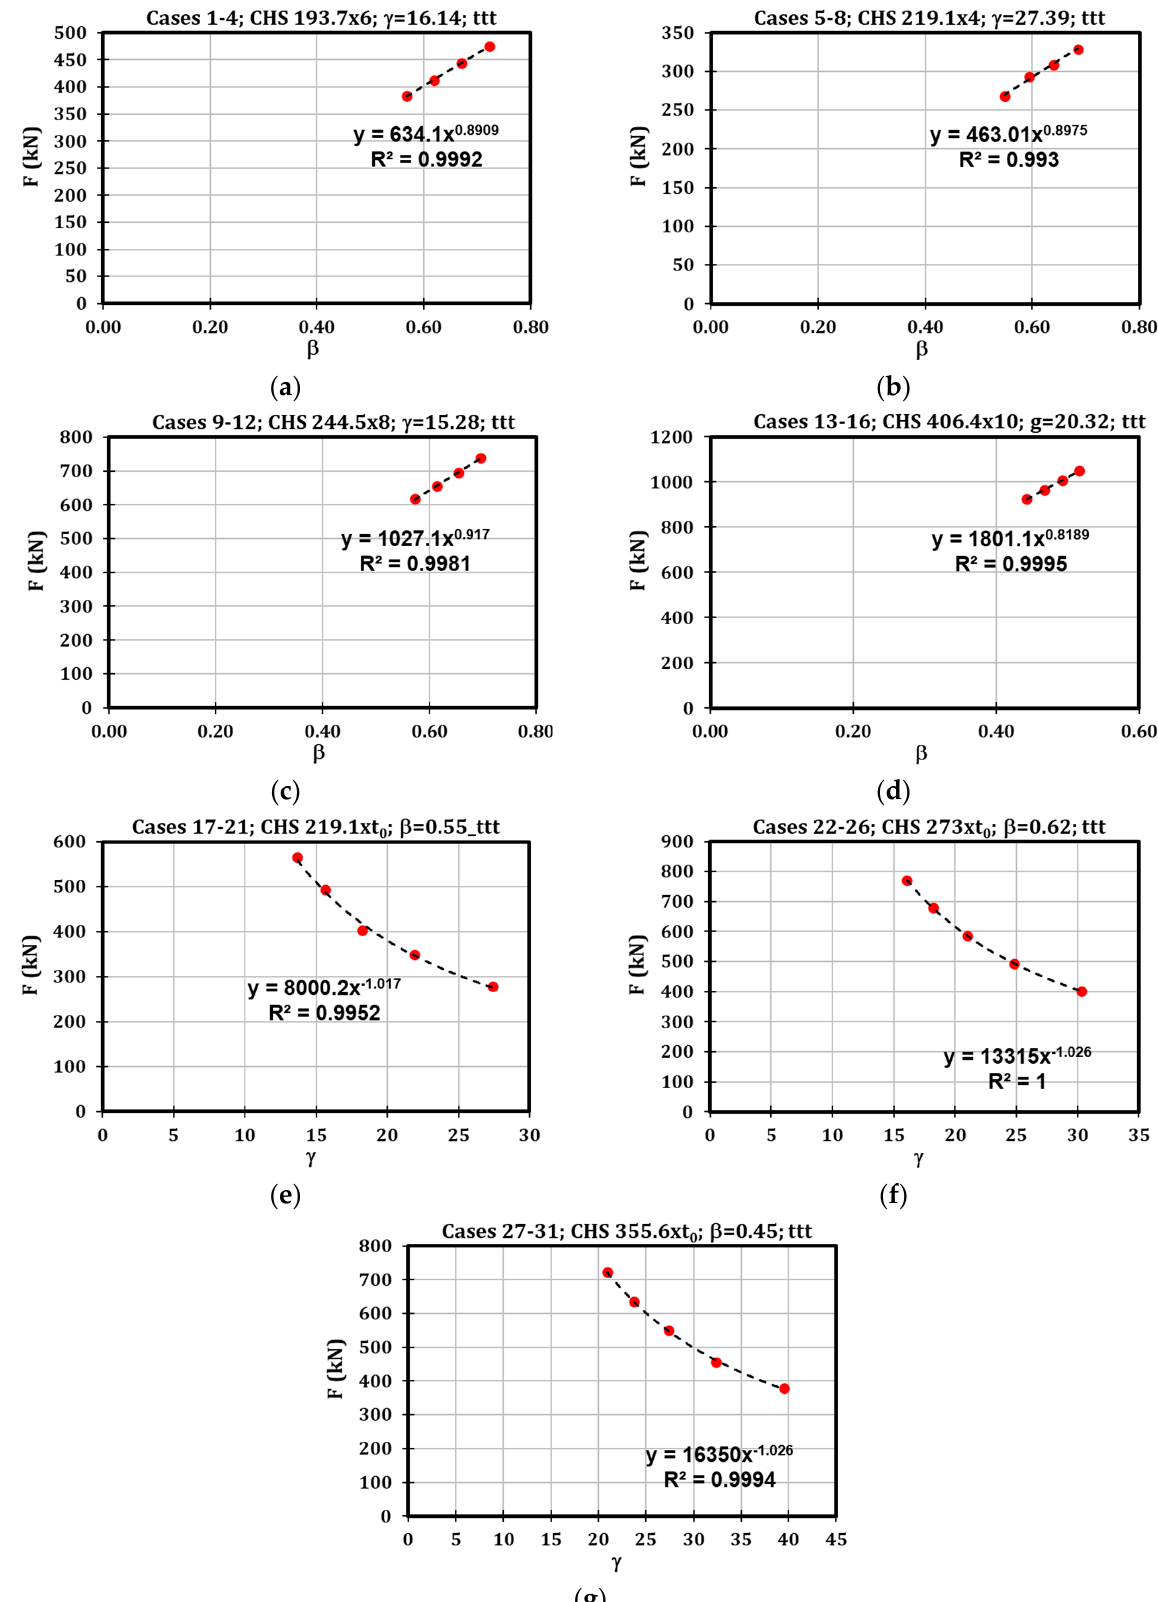
Figure 13. Results of the parametric analysis referring to F ttt Table 4. Validation of the proposed formulation related to the strength in tension.